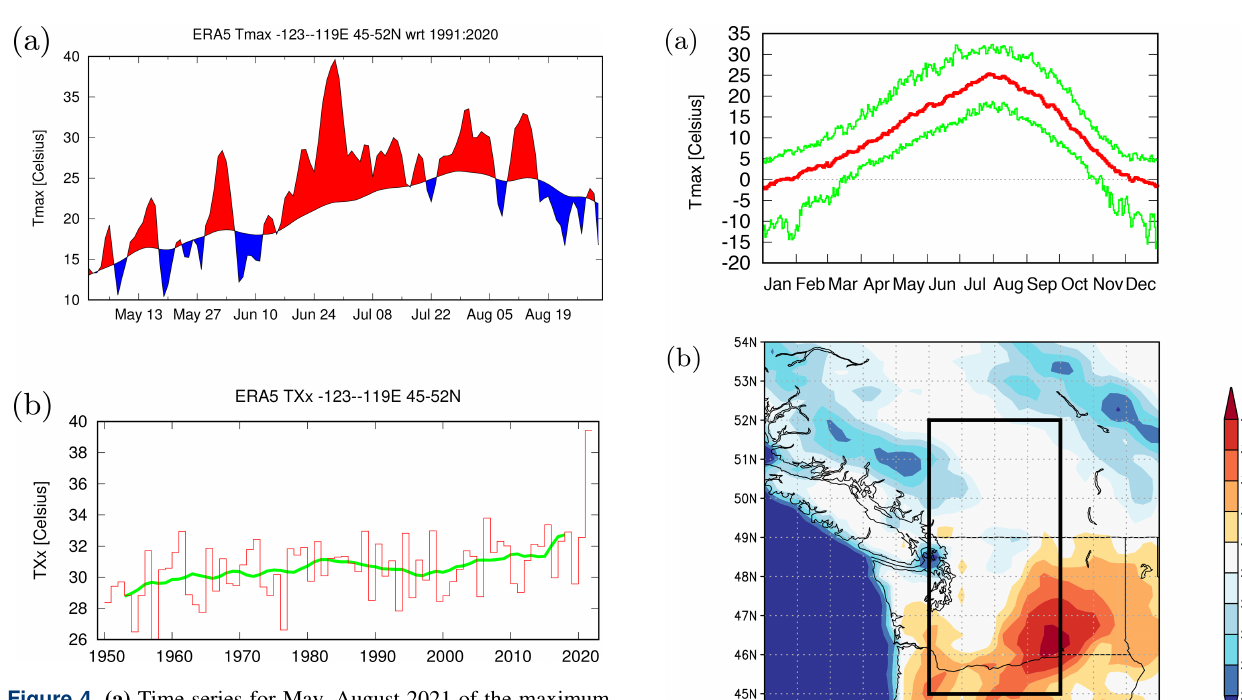
Figure 4. (a) Time series for May–August 2021 of the maximum daily temperature averaged over the study area based on ERA5, with positive and negative departures from the 1991–2020 climatologi- cal mean of daily maximum temperature shaded red and blue, re- spectively. (b) Annual maximum of the index series with a 10-year running mean (green line). Source: ERA5 (Hersbach et al., 2019). Figure 5.